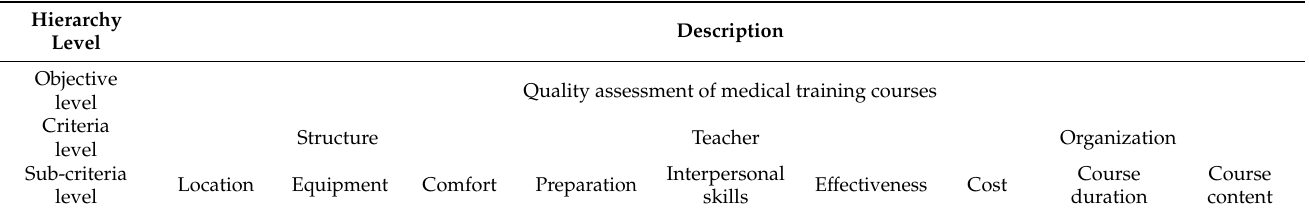
Table 2. Definition of the hierarchy of dominance according to the AHP.